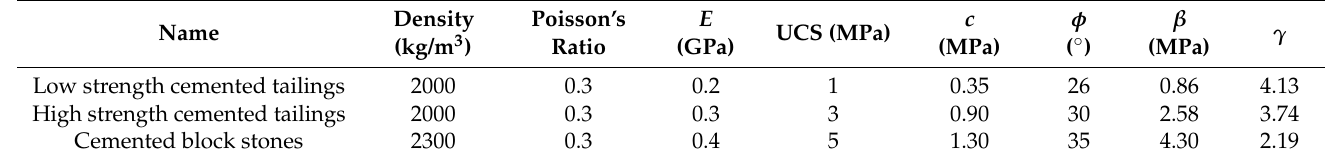
Table 3. The physical and mechanical parameters of backfill ( E is the Young’s modulus; c is the cohesion of the backfill; φ is the friction angle of the backfill; β and γ are residual strength